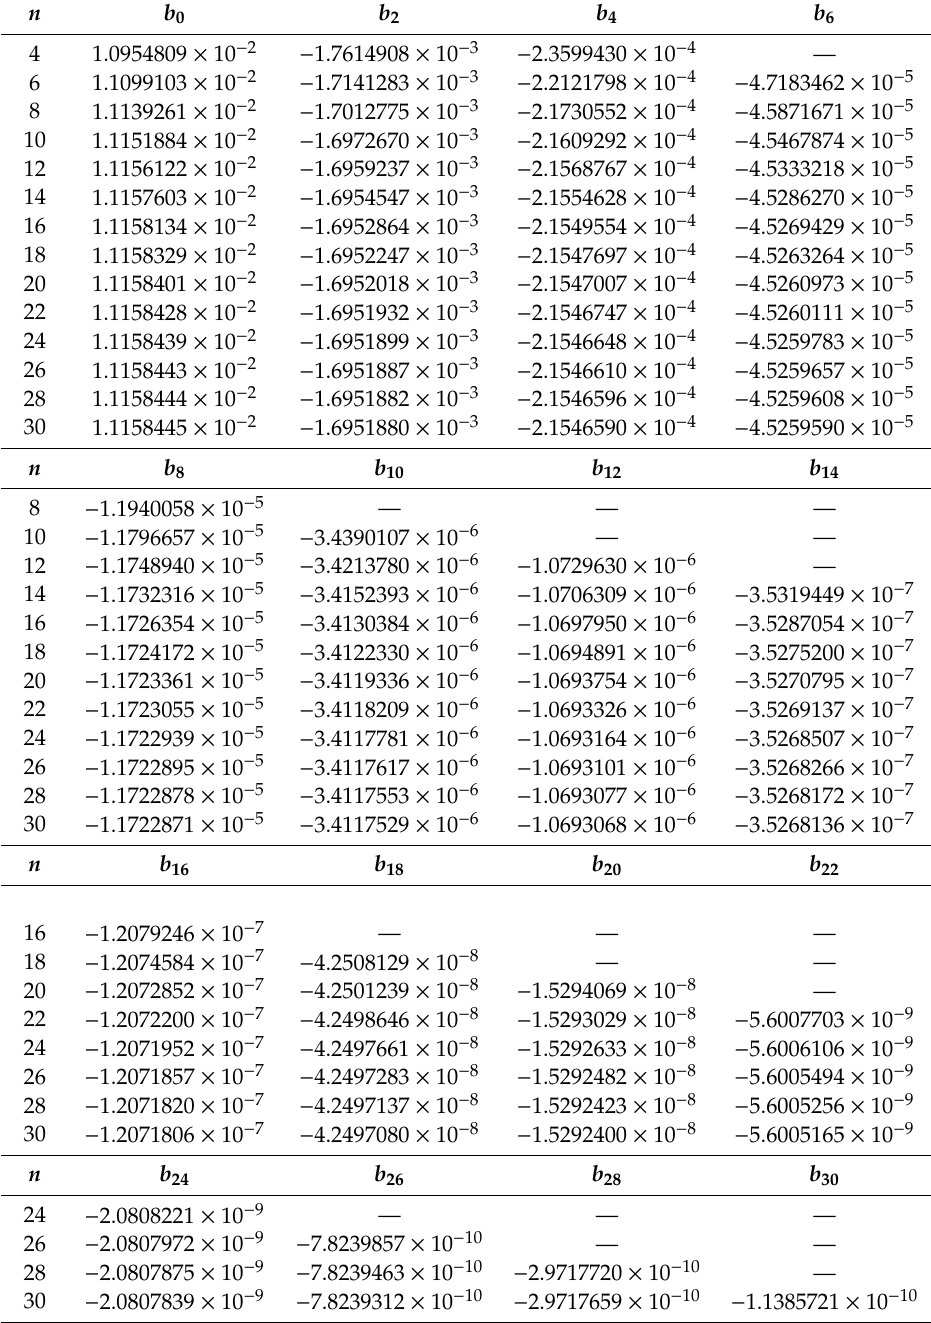
Table 1. The values of b 0 – b 6 , b 8 – b 14 , b 16 – b 22 and b 24 – b 30